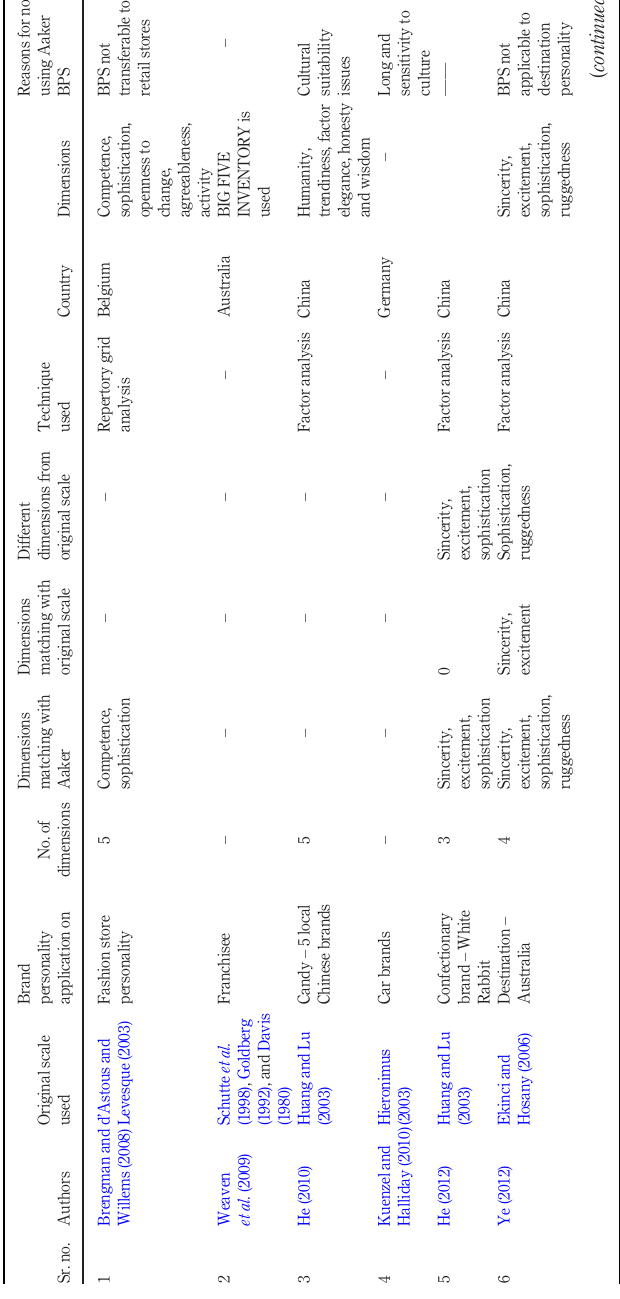
Table III. Avoidance of BPS with